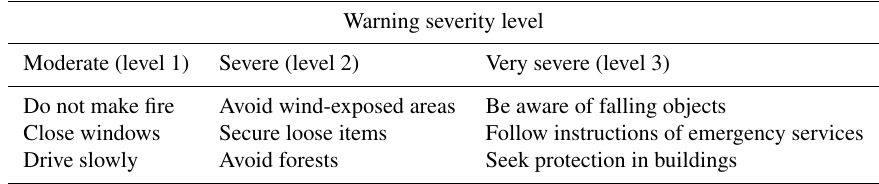
Table 1. Behavioral recommendations per severity level in the warning messages. Note that this list is not exclusive.